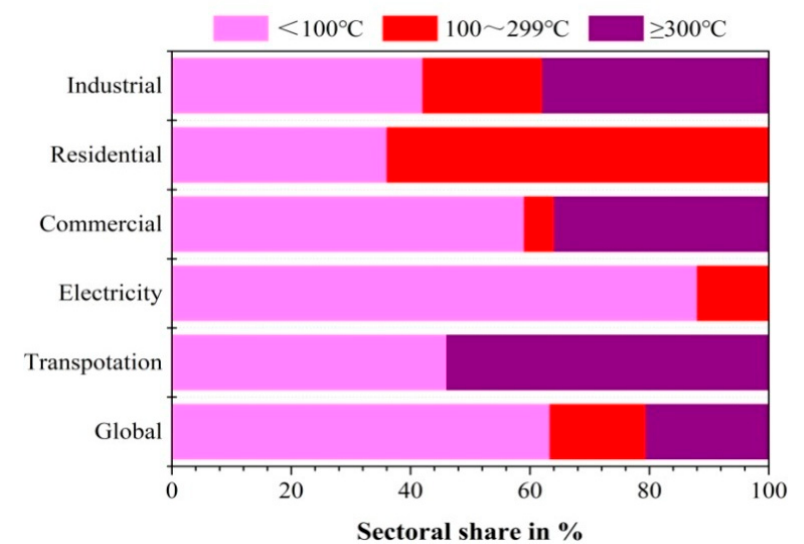
Figure 1. Sectoral shares of worldwide waste heat distribution [1].